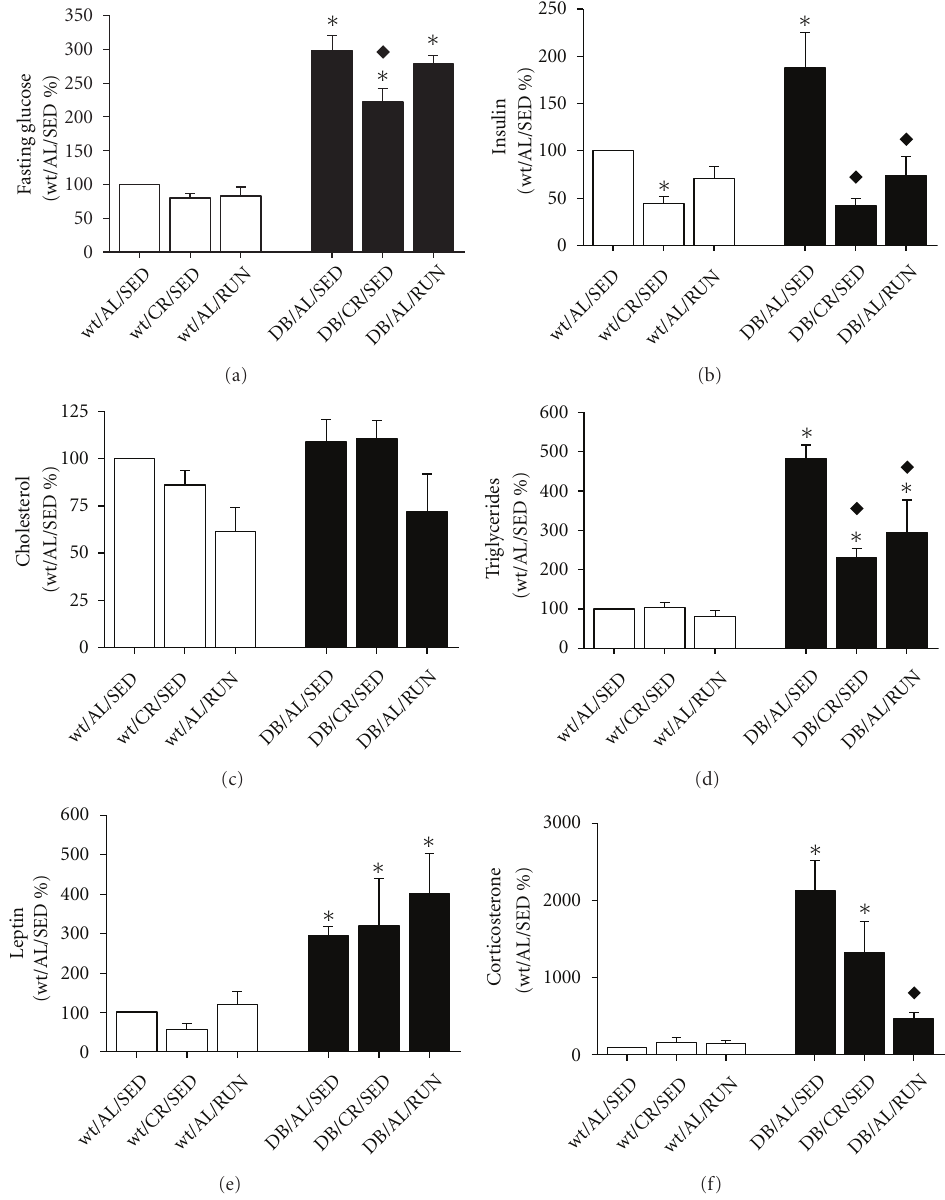
Figure 2: Endocrine changes in C57Bl/6 and db/db mice following running or caloric restriction. For all graphs, asterisk ( ∗ ) indicates significance at P < 0 . 05 relative to sedentary C57Bl/6 mice fed ad libitum . Black diamonds ( (cid:2) ) represent significance at P < 0 . 05 relative to sedentary db/db mice fed ad libitum . (a) Caloric restriction (CR) attenuates fasting hyperglycemia in db/db mice. (b) CR lowers circulating insulin concentrations in C57Bl/6 mice, and both running and CR reinstate normal insulin levels in db/db mice. (c) Although there is a trend towards reduced total cholesterol in runners, this did not reach statistical significance. (d) Serum triglycerides are elevated in db/db mice, but this elevation can be ameliorated following running or CR. (e) Serum leptin levels are increased in db/db mice across all conditions. (f) Running attenuates the elevated corticosterone levels observed in db/db mice. Abbreviations: wt = C57Bl/6; AL = ad libitum ; CR = caloric restriction; RUN = wheel running; DB = db/db